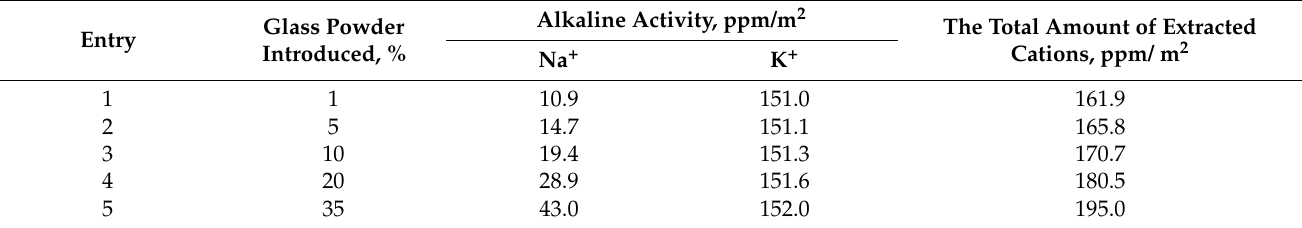
Table 4. The calculated alkaline activity of cement compositions with the addition of brown glass powder above 100% of cement CEM I 32.5